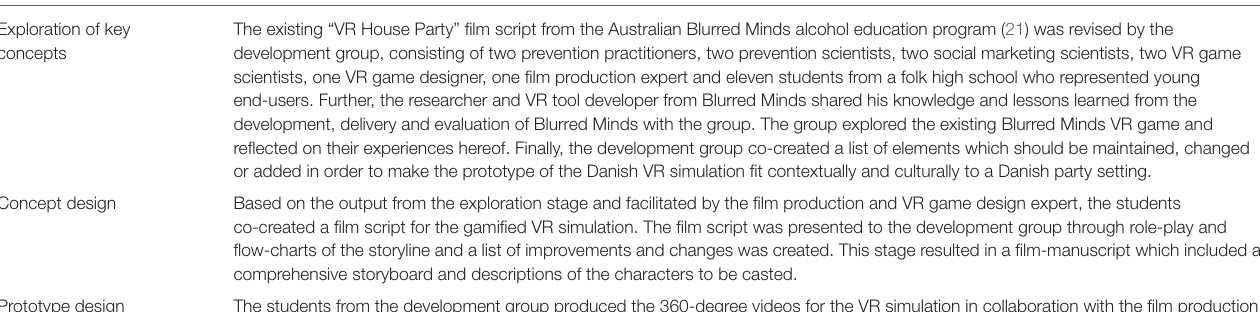
TABLE 2 | Using the Living Lab method to co-create VR FestLab. Living Lab